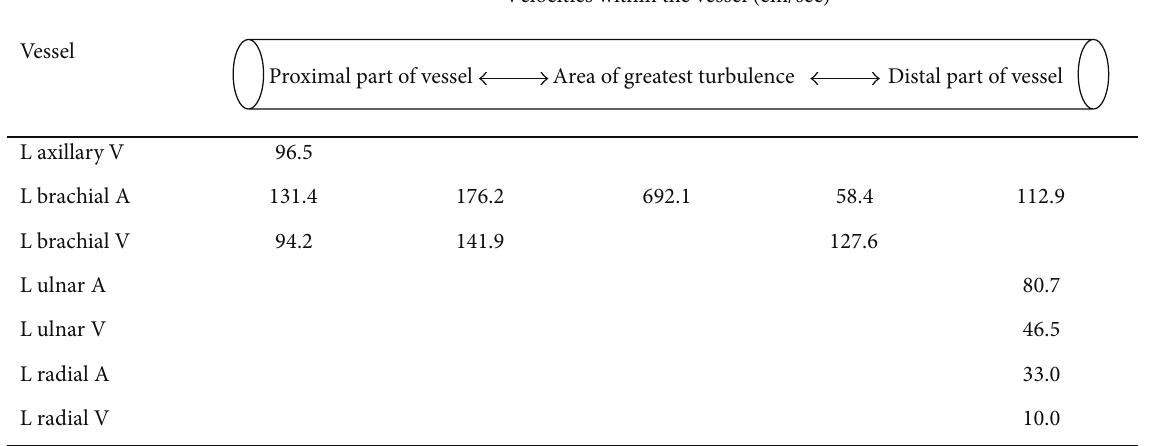
Pulmonary artery hypertension in our patient was com- plicated albeit masked by the presence of hyaline membrane disease from her prematurity, and the alterations in the right ventricular dimensions and function may already have begun earlier. The rapid progression of systolic dysfunction, however, shows the impact of the excessive venous return to the